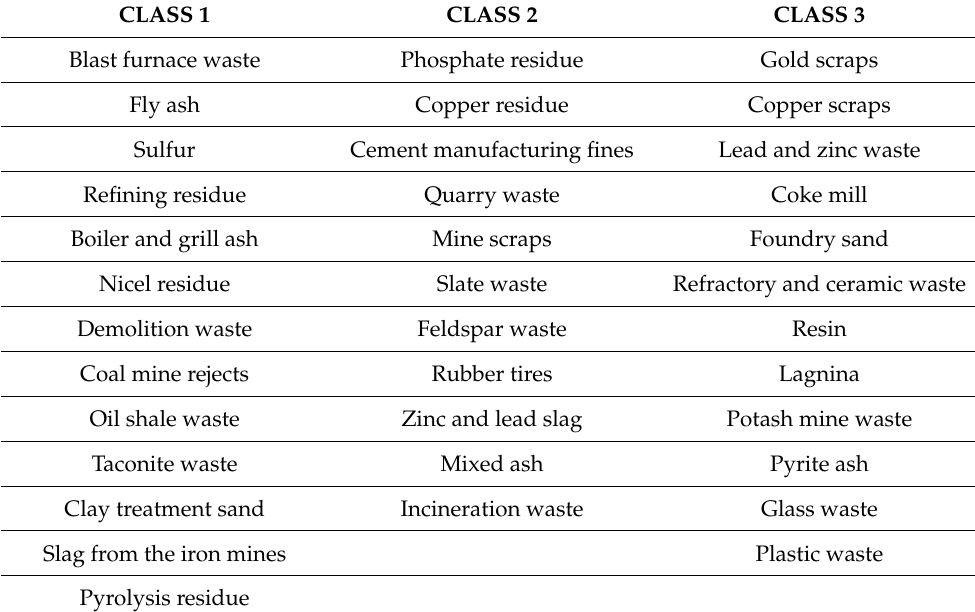
Table 2. Characteristics of Fly Ash